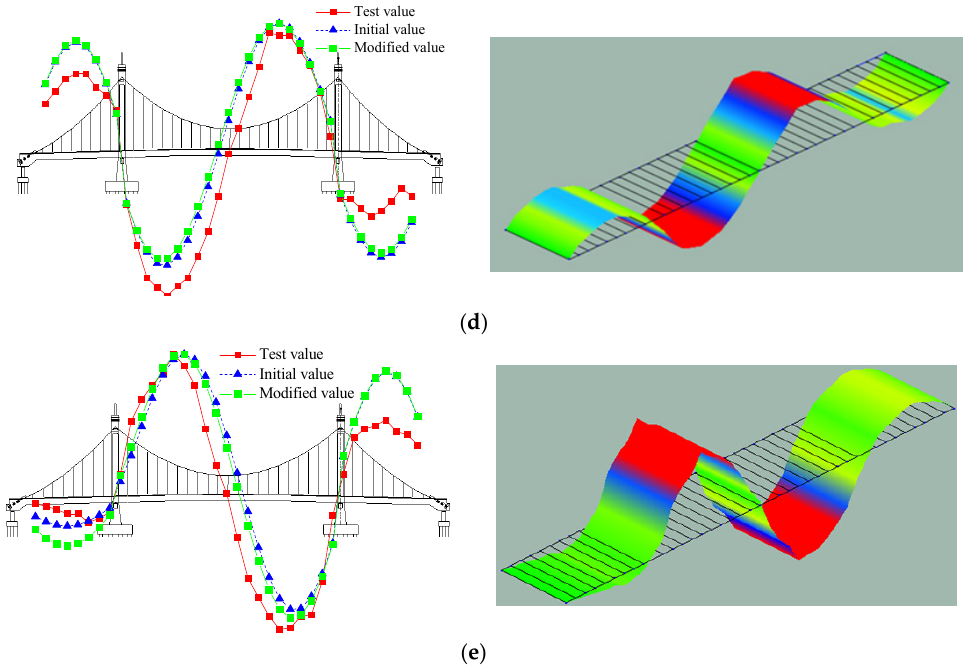
Figure 7. Comparisons of each vibration mode and images of each vibration mode form test: ( a ) Mode No. 1; ( b ) Mode No. 2; ( c ) Mode No. 3; ( d ) Mode No. 4; ( e ) Mode No. 5.